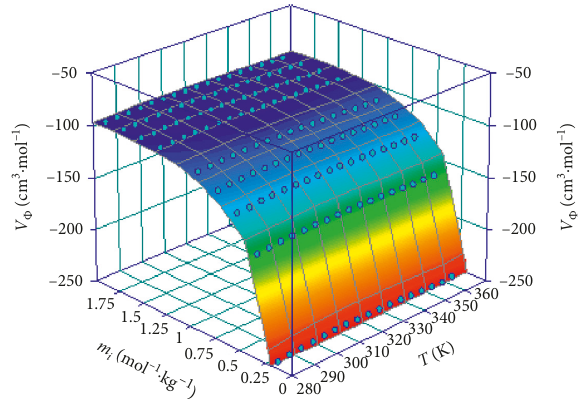
Figure 3: Apparent molar volumes of NaAsO against temperature and molality at atmospheric pressure.